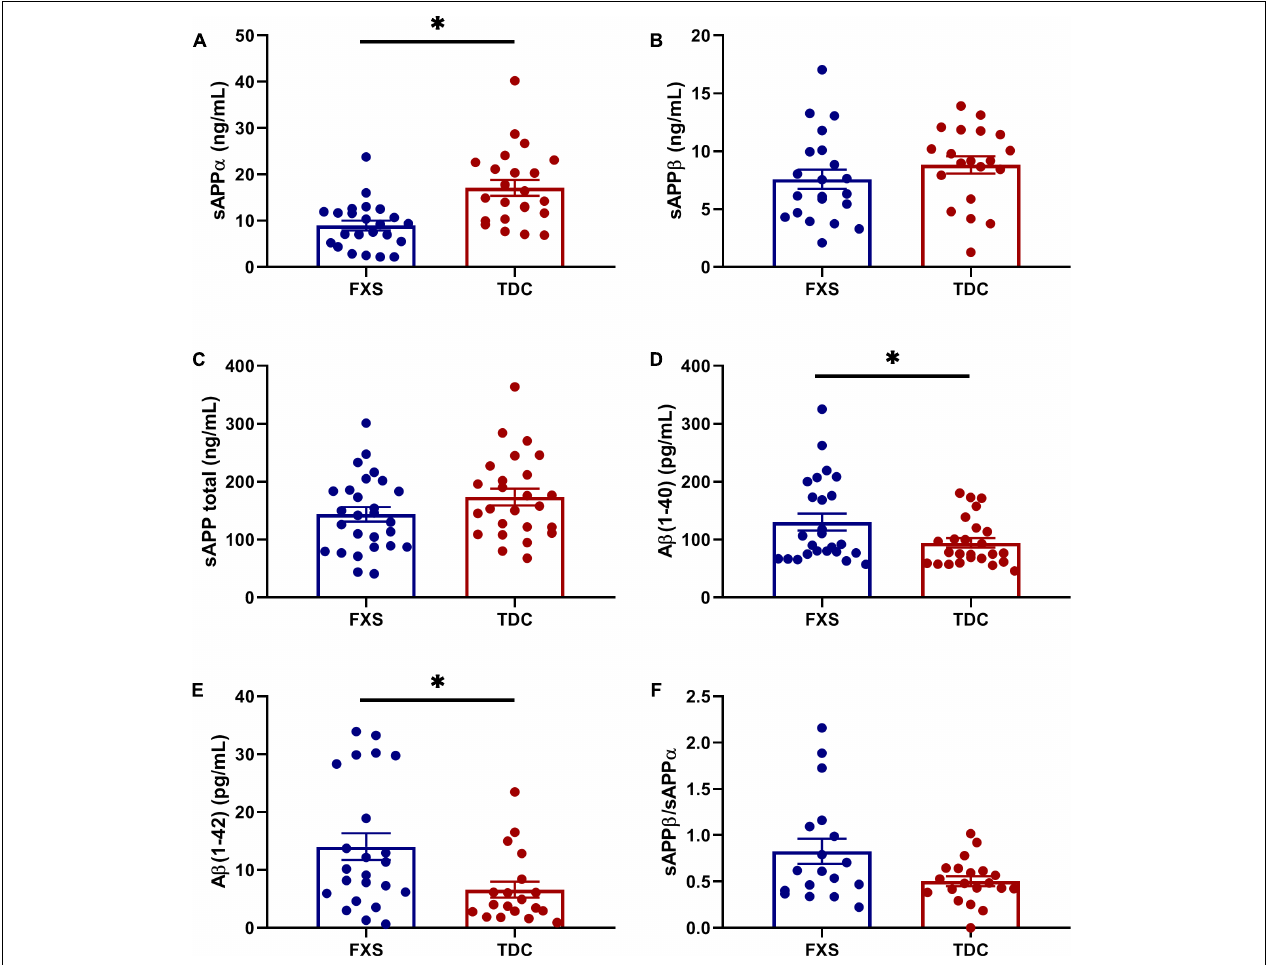
FIGURE 1 | Expression of APP metabolites in plasma from FXS and TDC subjects. Plasma levels of sAPP α , sAPP β , sAPP total ( α and β ), A β (1–40), and A β (1–42) were measured using ELISA in both FXS and TDC participants. Outliers determined by the ROUT method were excluded from analysis [sAPP α (FXS = 3, TDC = 1), sAPP β (FXS = 2, TDC = 1), A β (1–42) (FXS = 1, TDC = 3)]. (A) sAPP α was found to be significantly decreased in subjects with FXS as compared to controls ( p = 0.0003). (B,C) Neither sAPP β nor sAPP total levels were found to be significantly different between groups. (D,E) Both A β (1–40) and A β (1–42) were significantly increased in subjects with FXS as compared to controls ( p = 0.0169 and 0.0098). (F) No significant difference was observed in the ratio of sAPP β /sAPP α . ∗ p > 0.05.